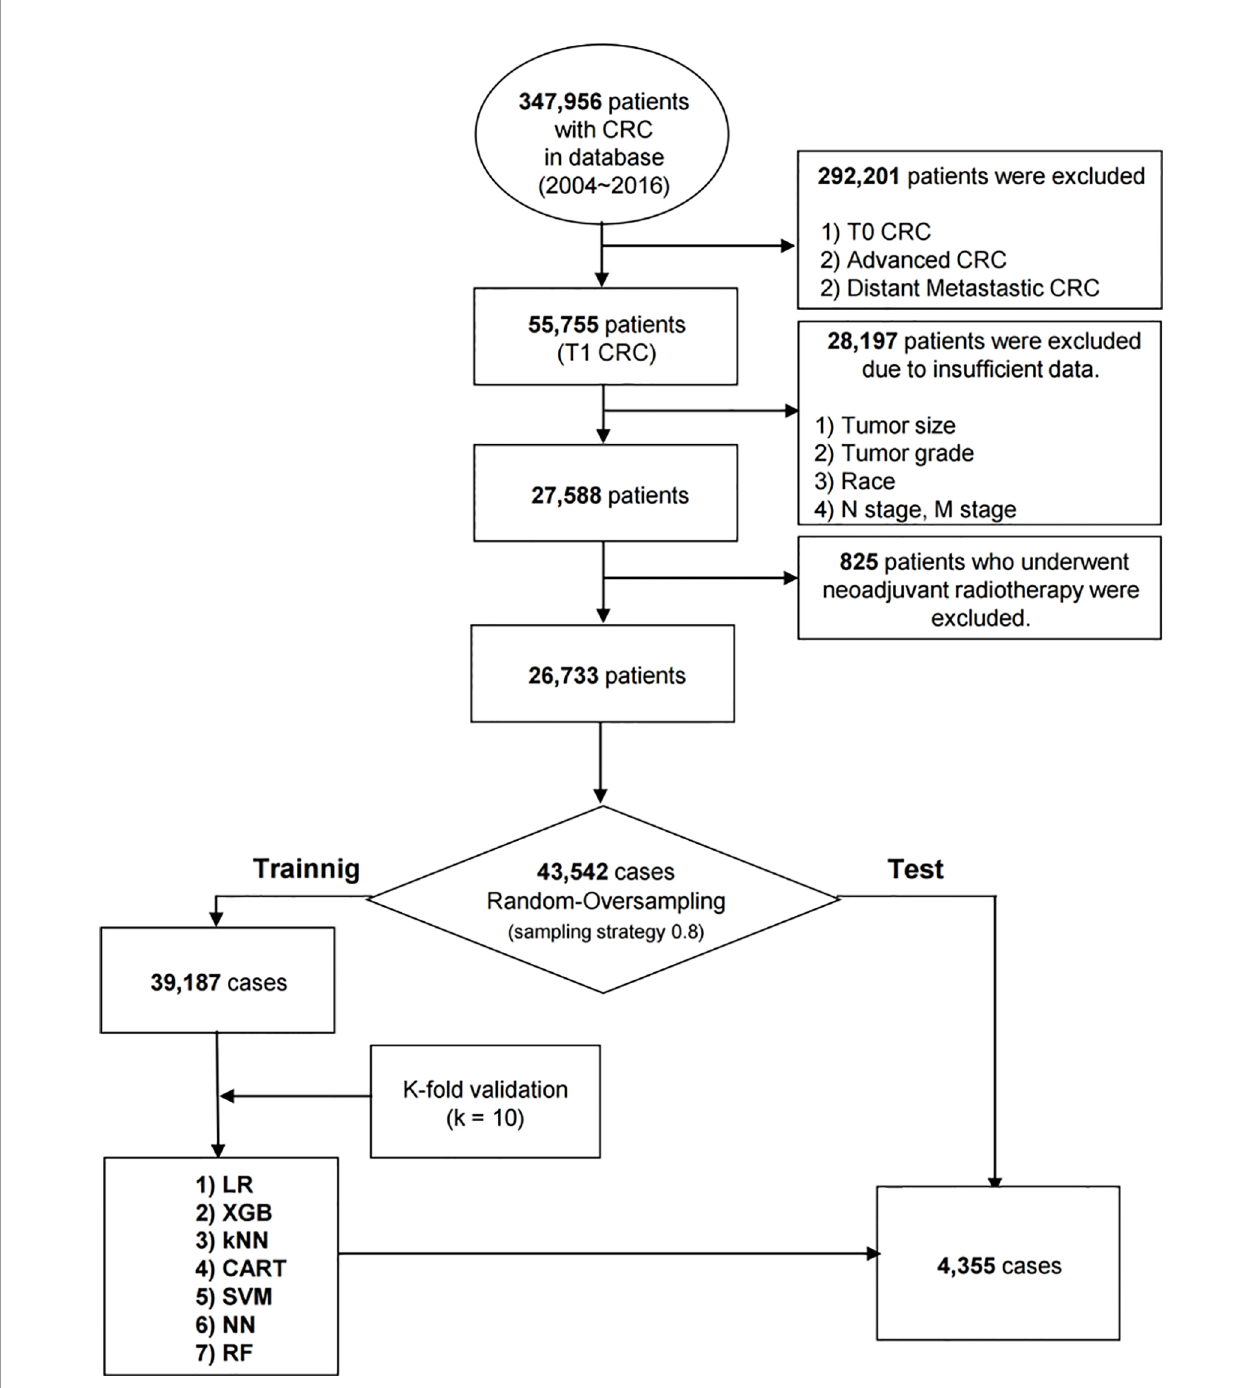
FIGURE 1 | The Work fl ow of the development